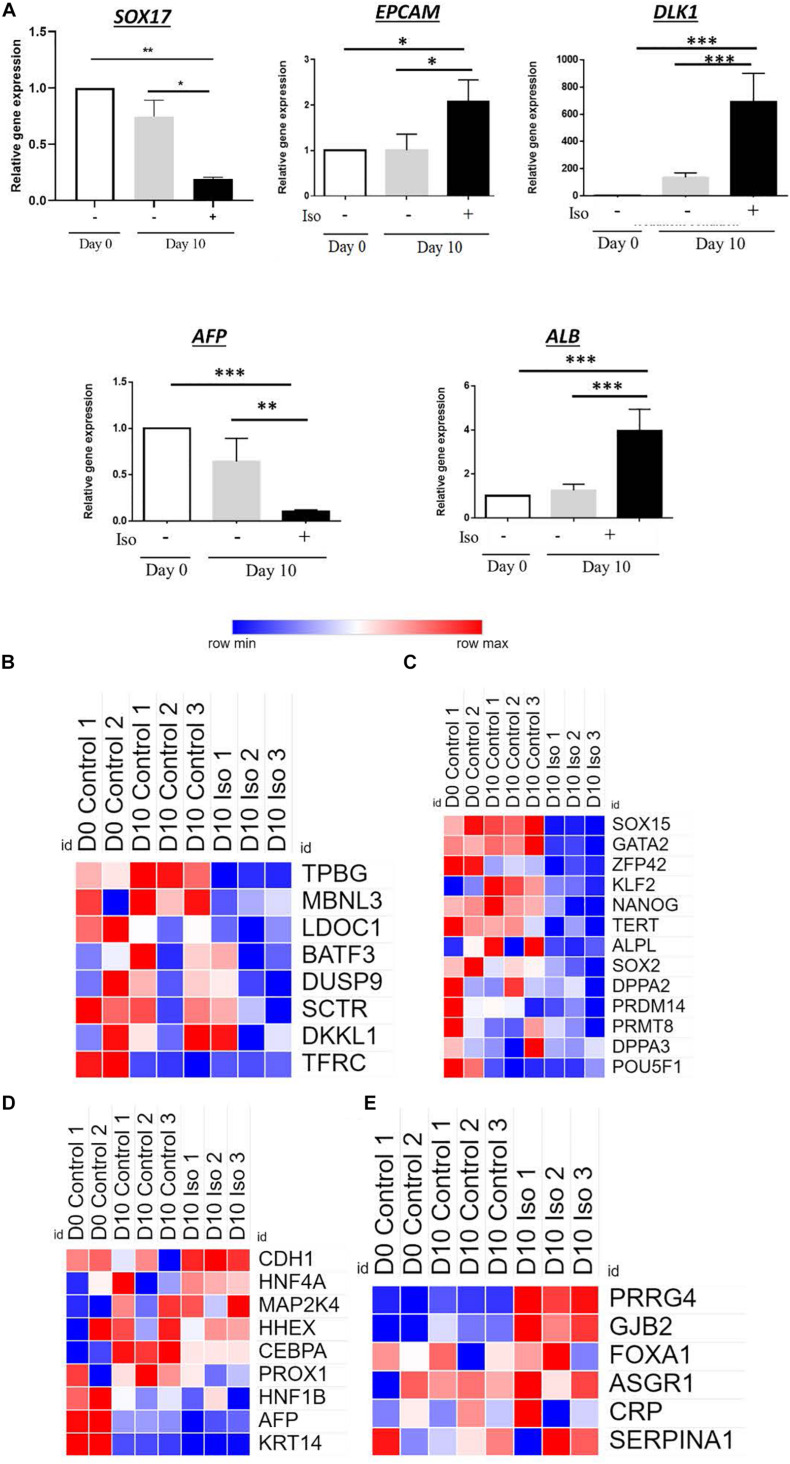
(A) Relative gene expression levels of hepatic progenitor markers. Heatmaps showing signal intensities (log2) of genes (from microarray analysis) related to (B) Undefined placenta, (C) Pluripotency, (D) Hepatoblast, and (E) Hepatocyte. *P < 0.05, **P < 0.01, ***P < 0.001.